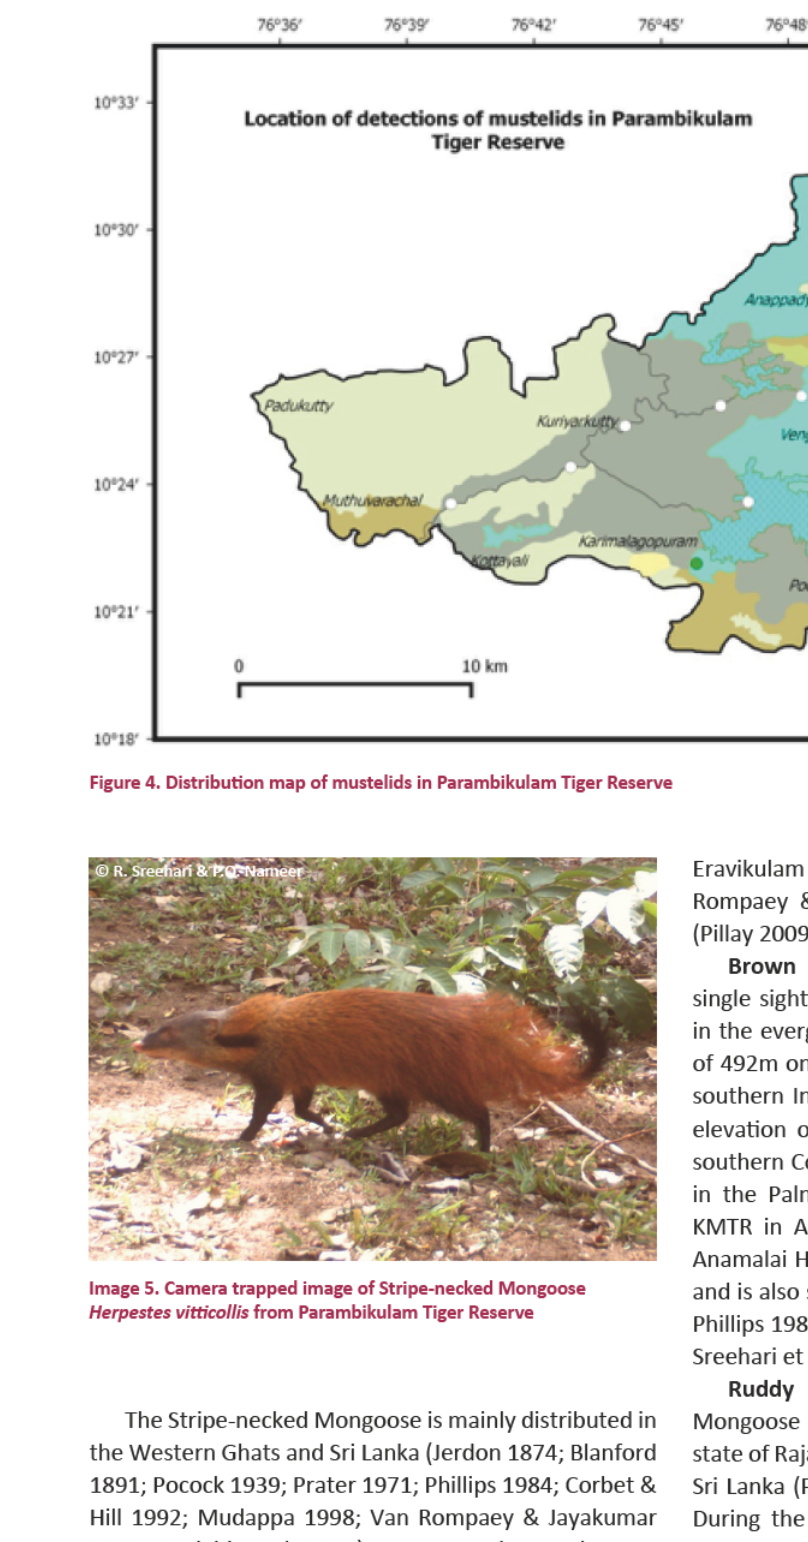
Image 5. Camera trapped fimage off Strfipe-necked Mongoose Herpestes vfificollfis ffrom Parambfikulam Tfiger Reserve